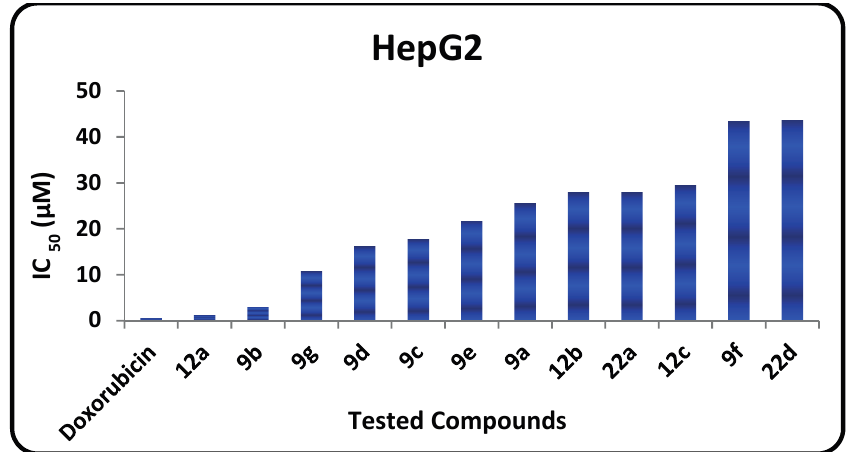
Figure 3. IC 50 values of tested compounds against